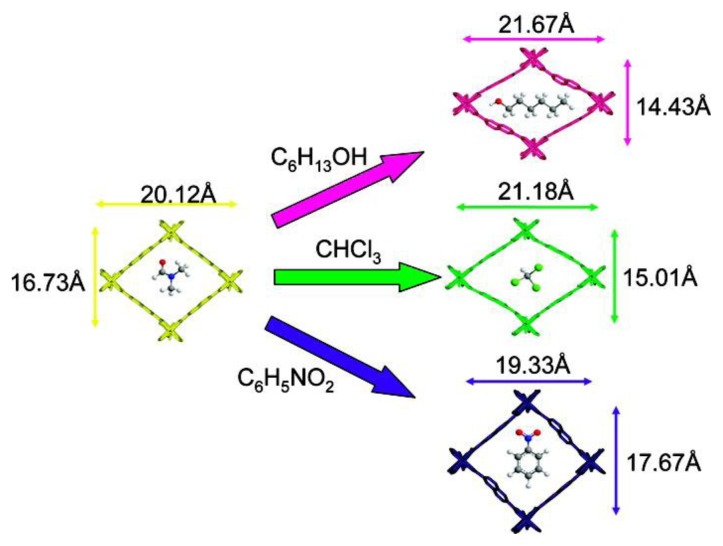
View of the pore systems of individual framework of Zn2(NDC)2DPNI·DMF (yellow), and the same frameworks with different guest such as C6H13OH (pink), CHCl3 (green) and C6H5NO2 (purple). Reprinted with permission from [194]. Copyright 2009, American Chemical Society.